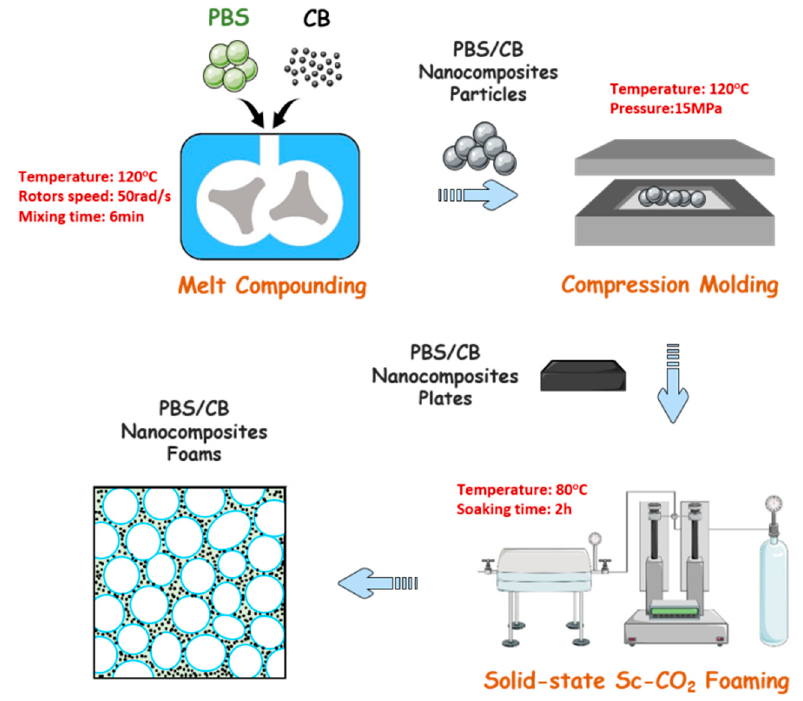
Figure 1. Schematic illustration of the preparation of lightweight microcellular poly(butylene succinate) (PBS)/carbon black (CB) nanocomposite foams.